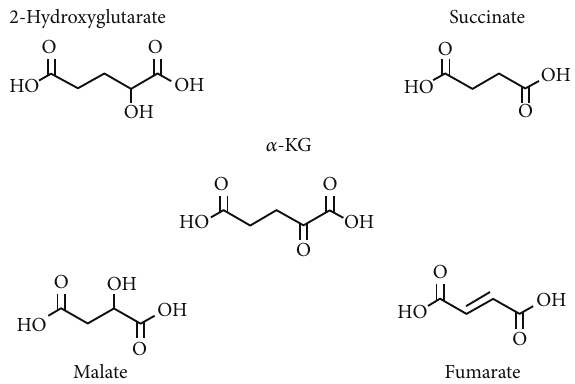
Figure 5: Structural similarity between TCA cycle oncometabolites. IDH gain of function mutations produces 2-hydroxy- 𝛼 -KG. SDH and FH mutations lead to accumulation of succinate and fumarate, respectively. MDH2 mutations result in increase of malate and